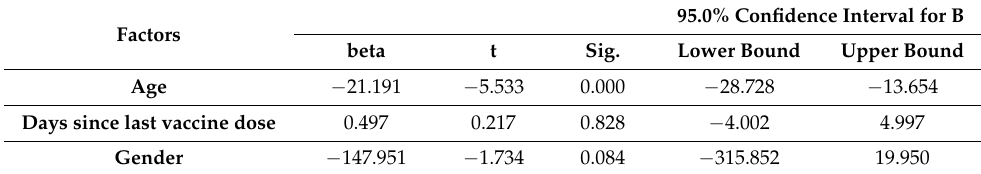
Table 2. Factors influencing the anti-SARS-CoV-2 antibody titre (linear regression analysis).